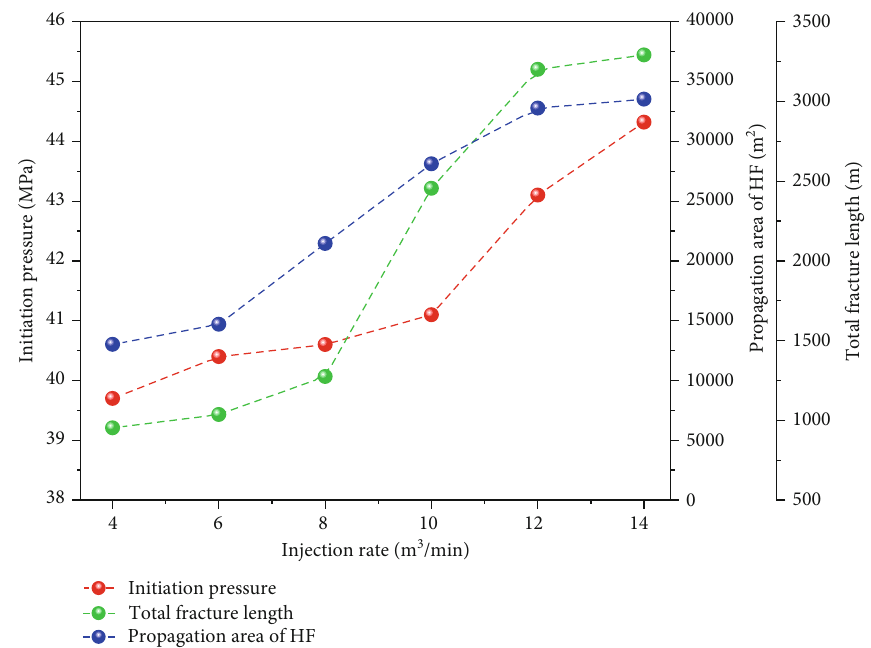
Figure 20: Total equivalent hydraulic fracture length and propagation area of the complex fracture